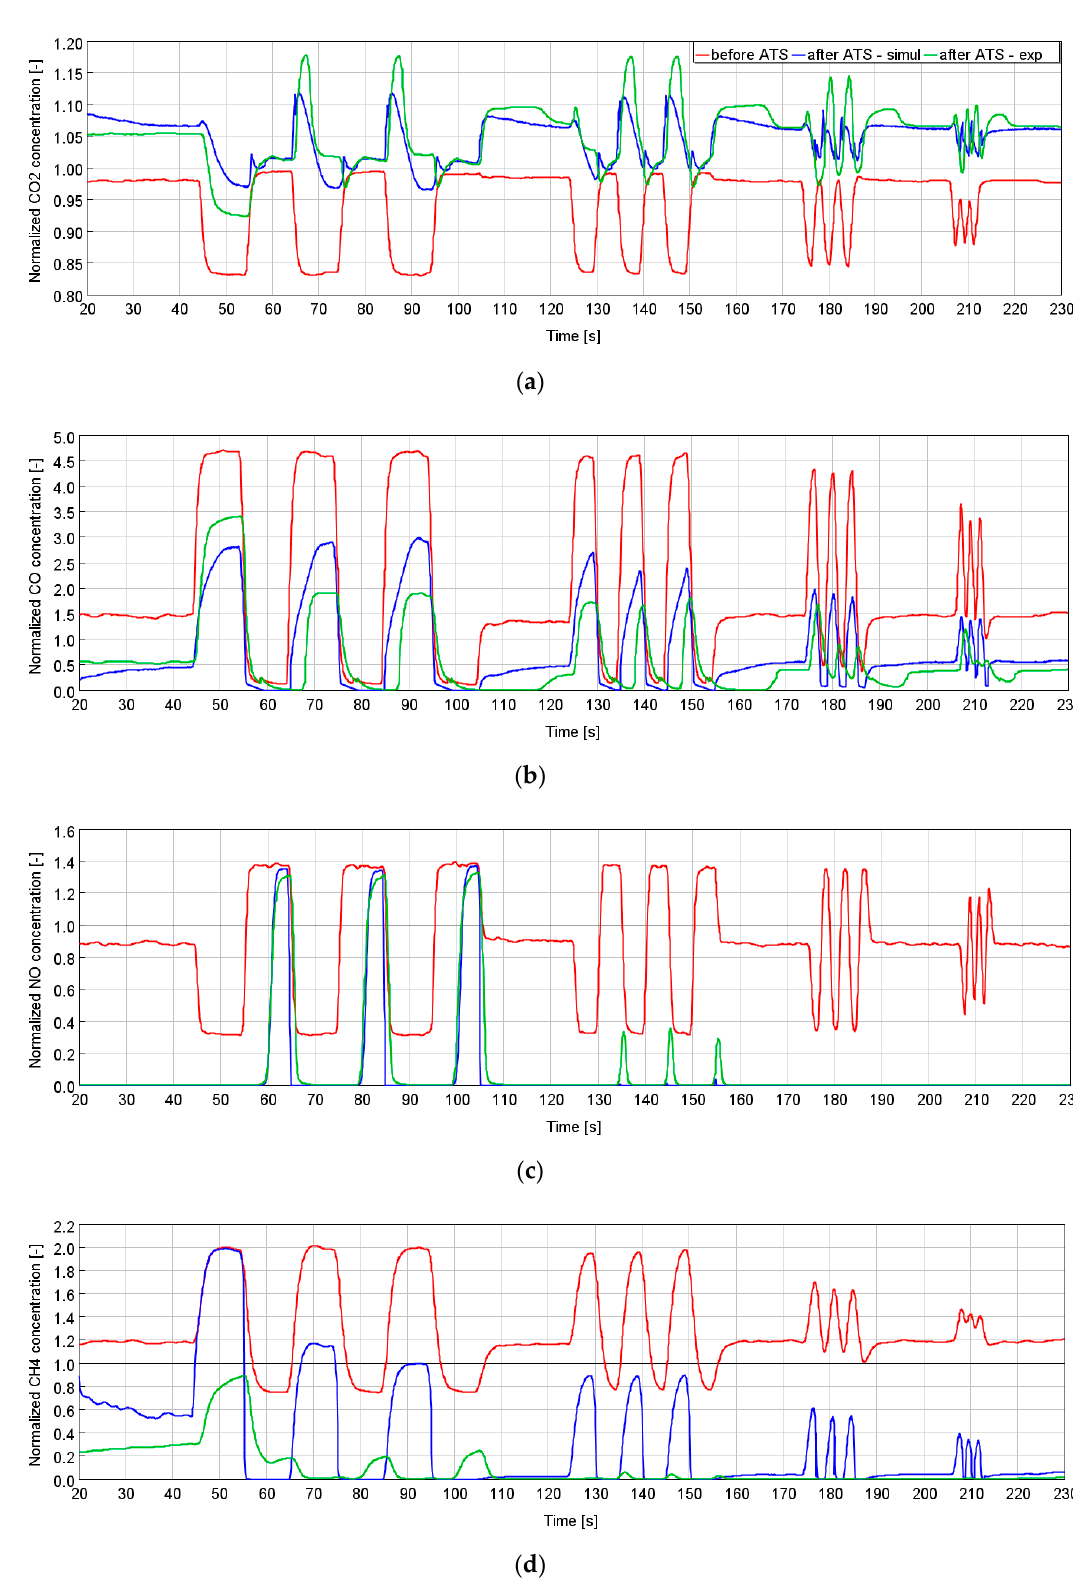
Figure 12. Transient conditions at 40% Load. Gas Temperature ≈ 620 °C ( a ) Num/Exp. CO 2 engine out and tailpipe concentration. ( b ) Num/Exp. CO engine out and tailpipe concentration. ( c ) Num/Exp. NO engine out and tailpipe concentration ( d ) Num/Exp. CH 4 engine out and tailpipe concentration.